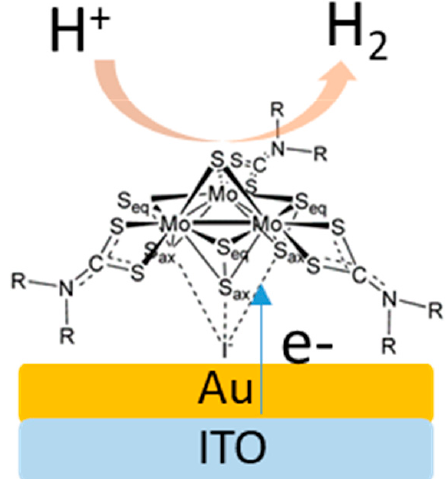
Figure 3. Schematic of [Mo 3 S 7 (S 2 CNMe 2 ) 3 ] + monolayer-coated Au electrode surface for the catalytic proton reduction reaction.